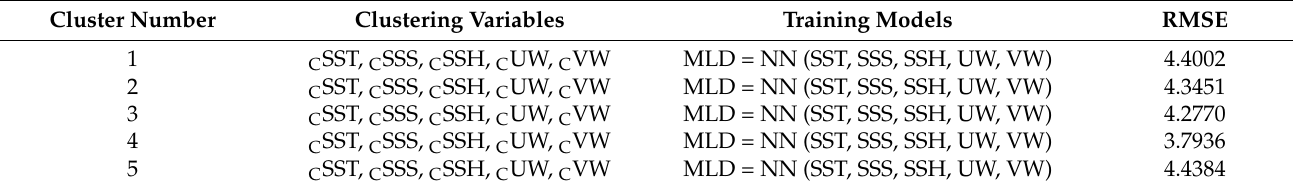
Table 3. Design of